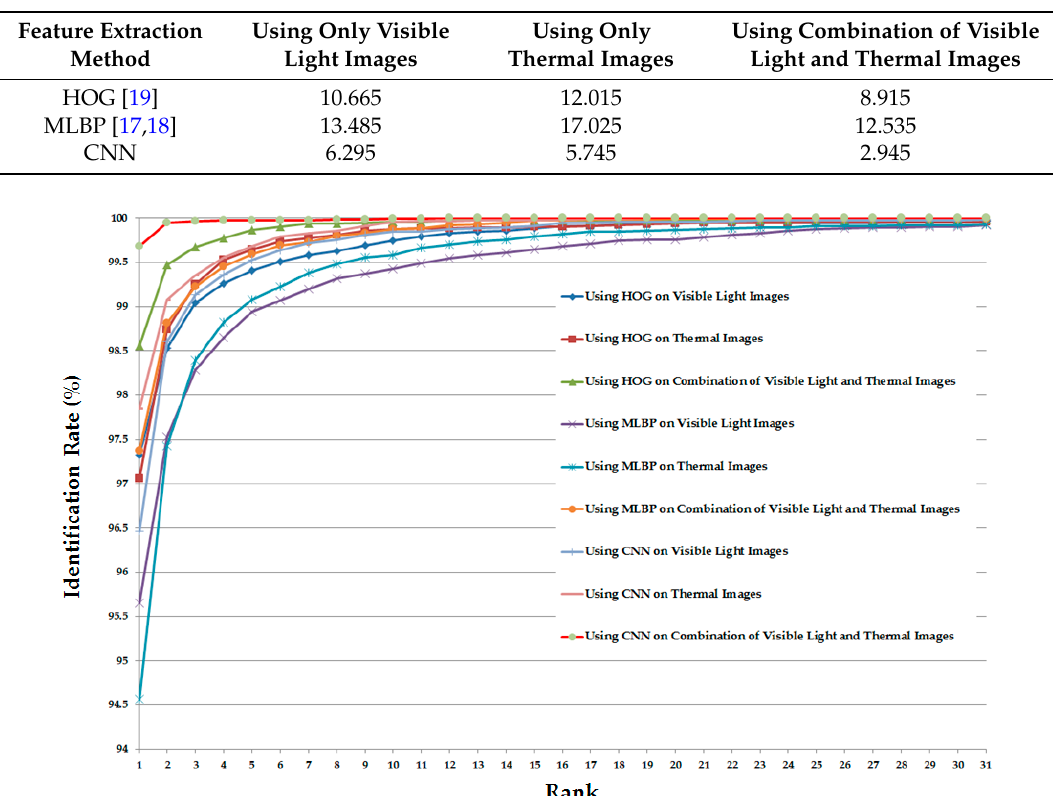
Table 5. Verification accuracy (EER) of the recognition system using Euclidean distance with PCA applied on extracted image features (unit: %).